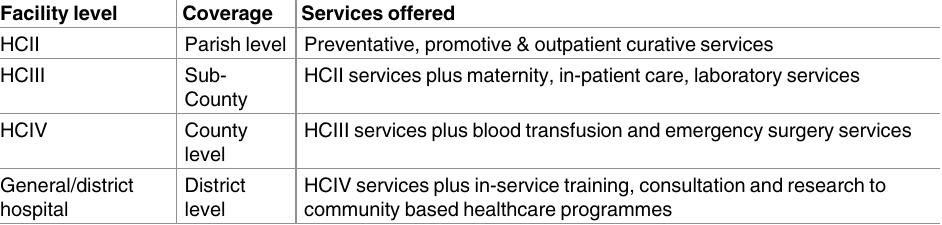
Table 1. Summary of servicesoffered at different facility